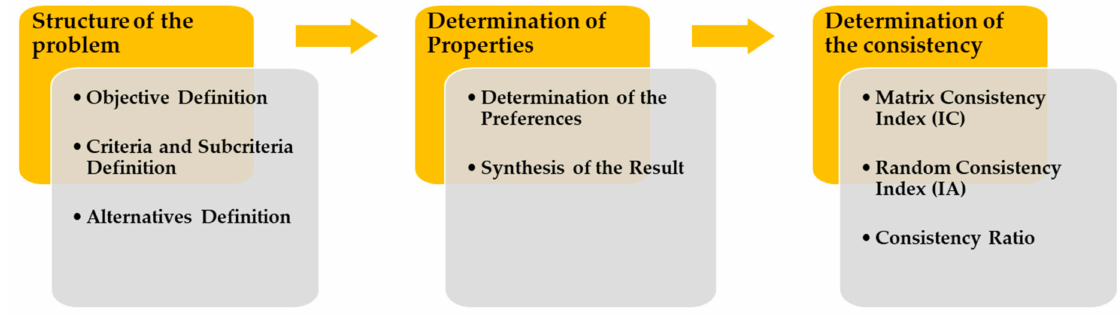
Figure 1. Phases of AHP.